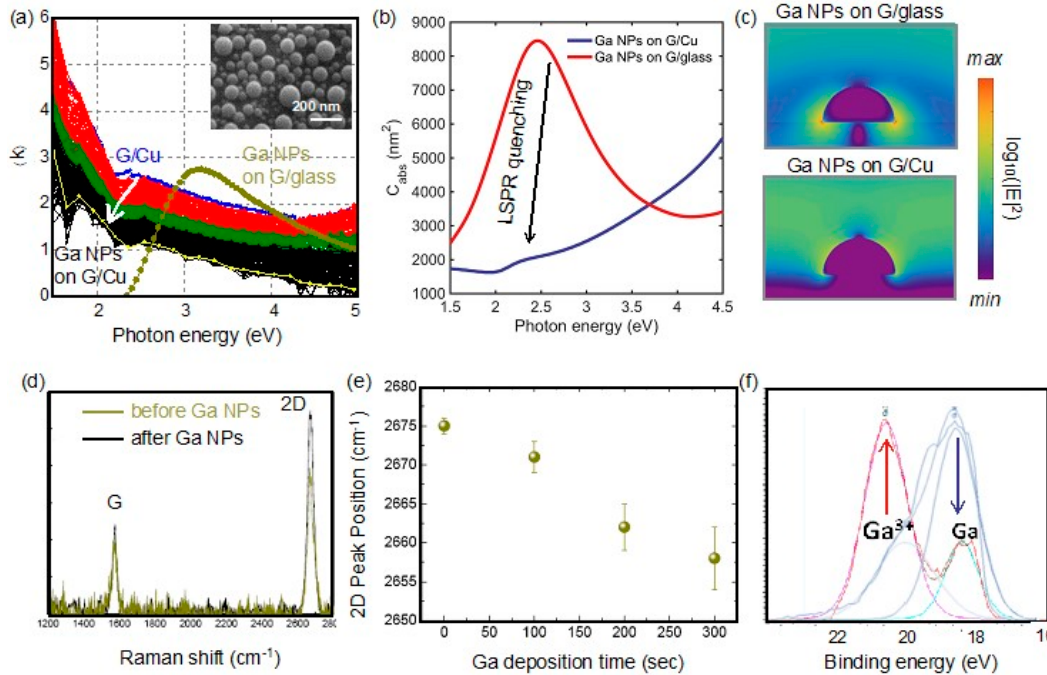
Figure 2. Ga NPs on G / Cu support. ( a ) Experimental extinction coe ffi cient spectra (cid:104) k (cid:105) recorded in real time during Ga NP deposition on the G / Cu substrate. Each spectrum is acquired every 1 sec; the blue spectrum refers to the initial G / Cu sample, while the last yellow spectrum refers to the Ga NP / G / Cu; the arrow indicates Ga NP deposition. For comparison, the (cid:104) k (cid:105) spectra for Ga NPs on G / glass are also shown. As an inset is shown an SEM image of the NP morphology. ( b ) Calculated absorption cross-section of a R = 55 nm Ga hemisphere on G / Cu and G / glass substrates illuminated under normal incidence. ( c ) Near-field distribution of the electromagnetic field when the Ga NPs are excited at 3 eV when deposited on G / Cu (bottom) and G / glass substrates (top). ( d ) Raman spectra of the graphene layer before and after Ga NP deposition. ( e ) Graphene 2D band position as a function of Ga deposition time. ( f ) X-ray photoelectron spectroscopy (XPS) spectra of the photoelectron core level Ga3 d on G / Cu (red curve) compared to that of Ga NPs on an insulating glass substrate (blue curve). involved materials ( 𝜙 (cid:3007)(cid:3008)(cid:3028) = 4.2 eV, 𝜙 (cid:3007)(cid:3008) = 4.5 eV and 𝜙 (cid:3007)(cid:3004)(cid:3048) = 4.9 eV), as depicted in the schema in Figure 231